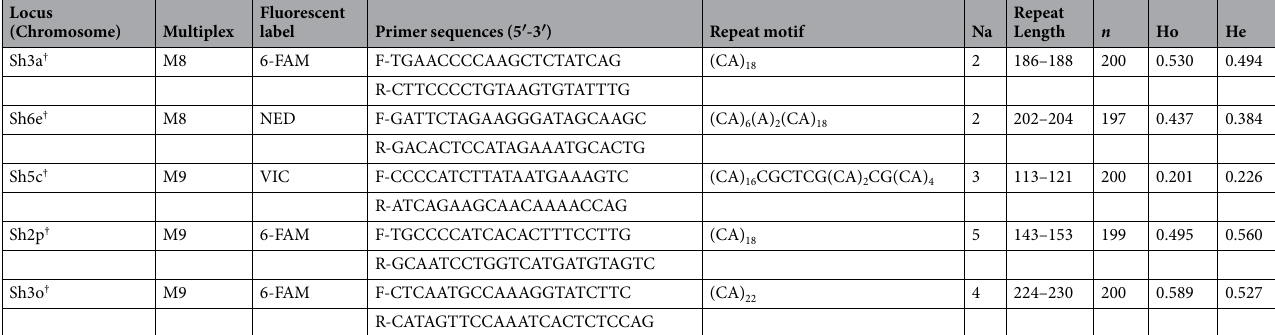
(Table 2). PCRs were performed following the standard protocol for the Qiagen Type-it Microsatellite kit, with the modification that the reaction size totalled 10 µ L. Fragments were separated on an ABi3300 using GeneScan ™ 500